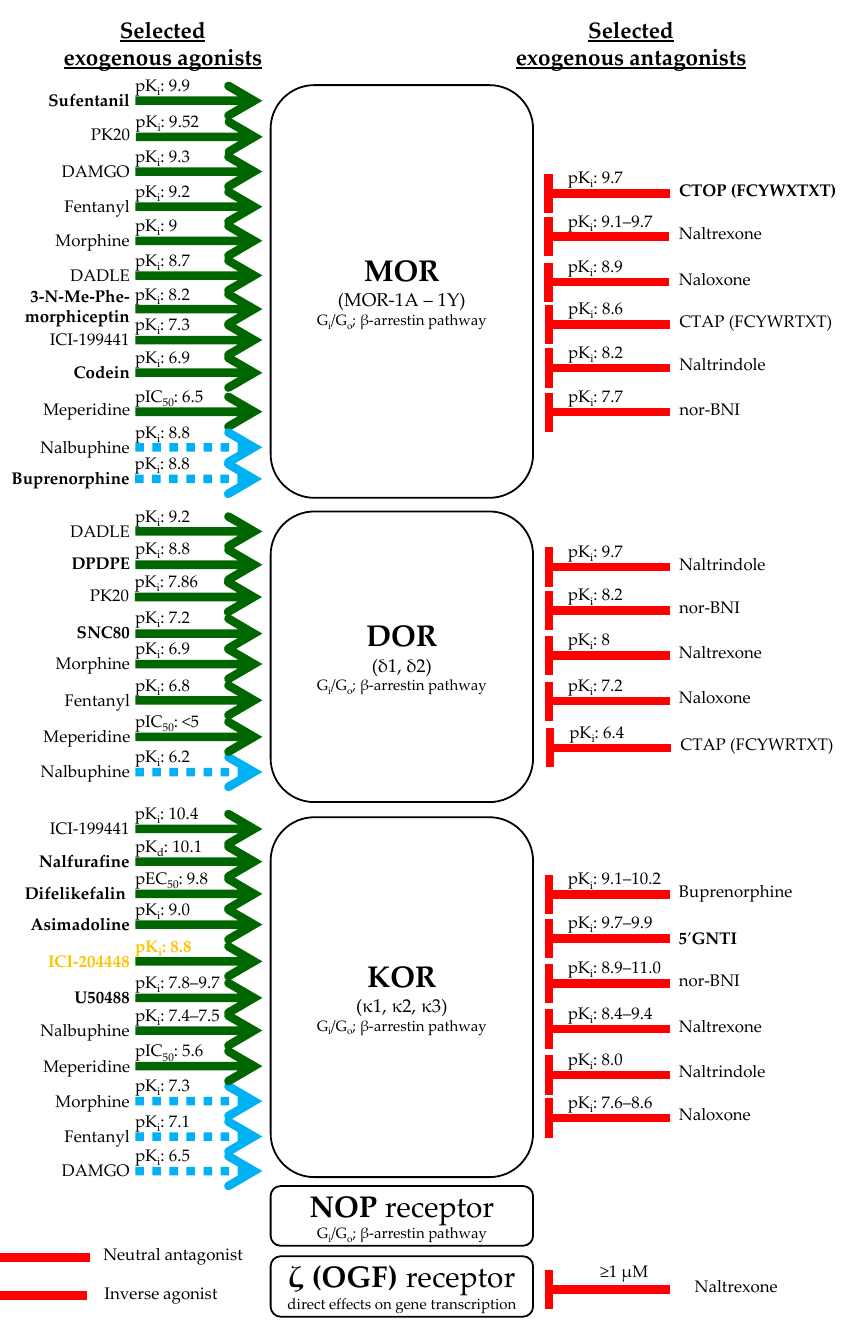
Figure 1. Overview of the major opioid receptors and their most important exogenous ligands mentioned in the text. Affinity data are obtained from the IUPHAR Guide to Pharmacology database (accessed on 5 December 2021) or (in case of PK20) from Ref [82]. When available, affinities for the human receptors are shown. If such data were not available, animal data are given (indicated by yellow fonts ). Bold characters highlight apparently selective compounds (i.e., compounds that have no other targets according to the said database). Note that, unlike the other opioid receptors, ζ (OGF) receptor is normally expressed in the nuclear envelope. Upon binding OGF, it translocates to the nucleus, where it directly regulates gene expression [79]. Please note that we only provide affinity but not efficacy data of the substances.